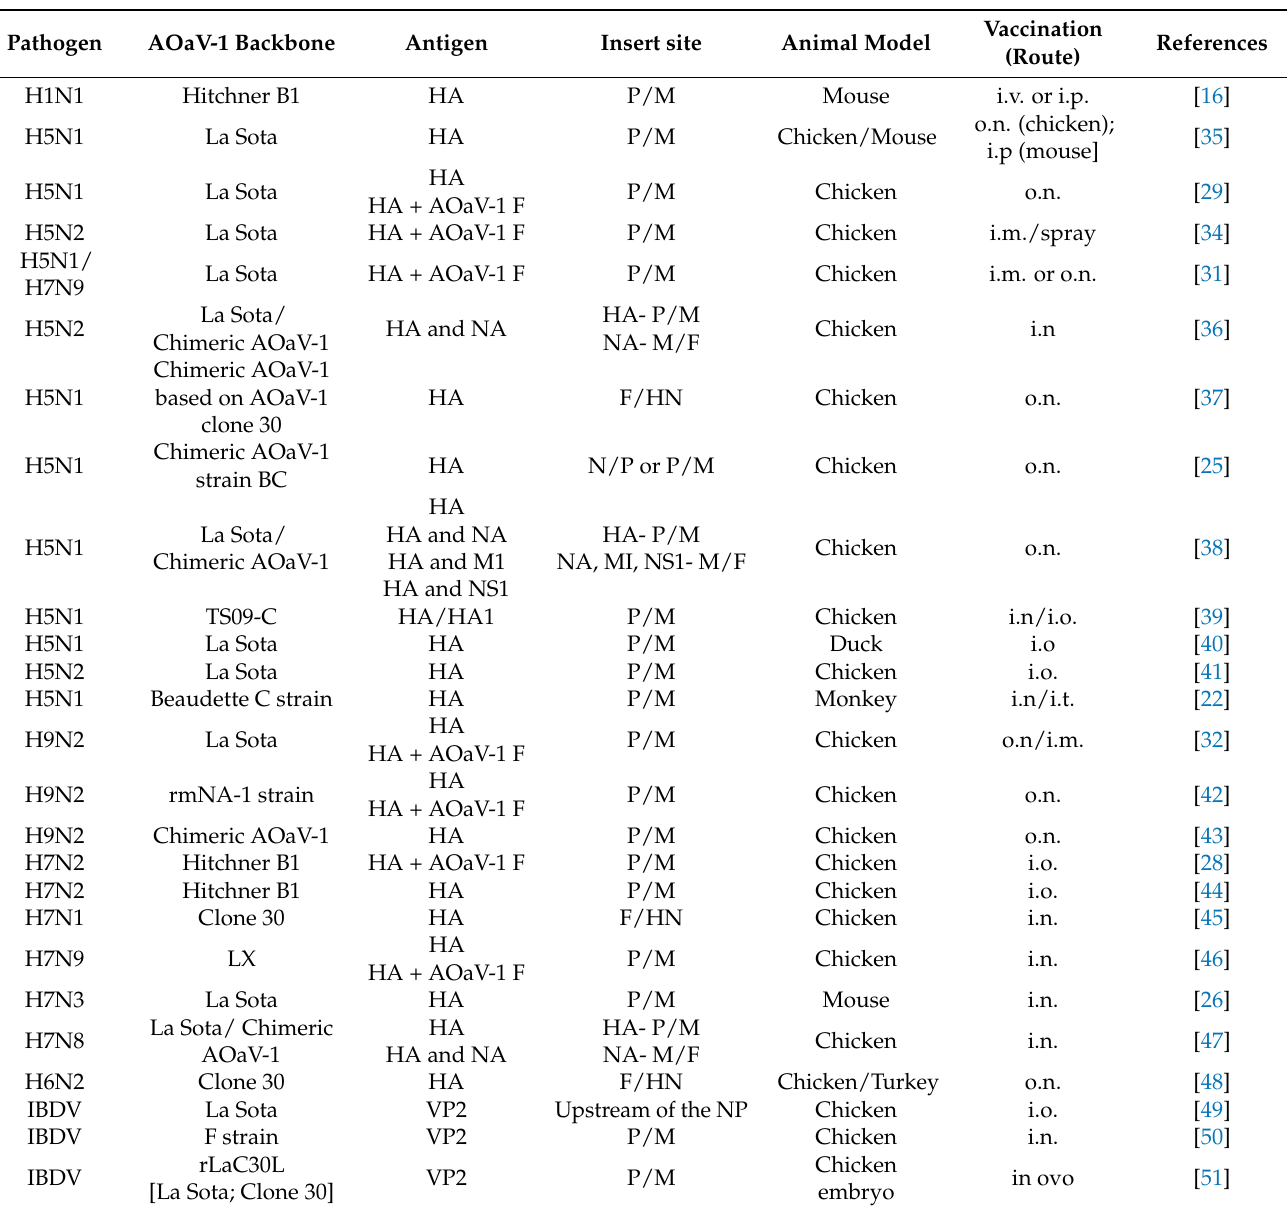
Table 1. Candidate AOaV-1-vectored vaccines for poultry